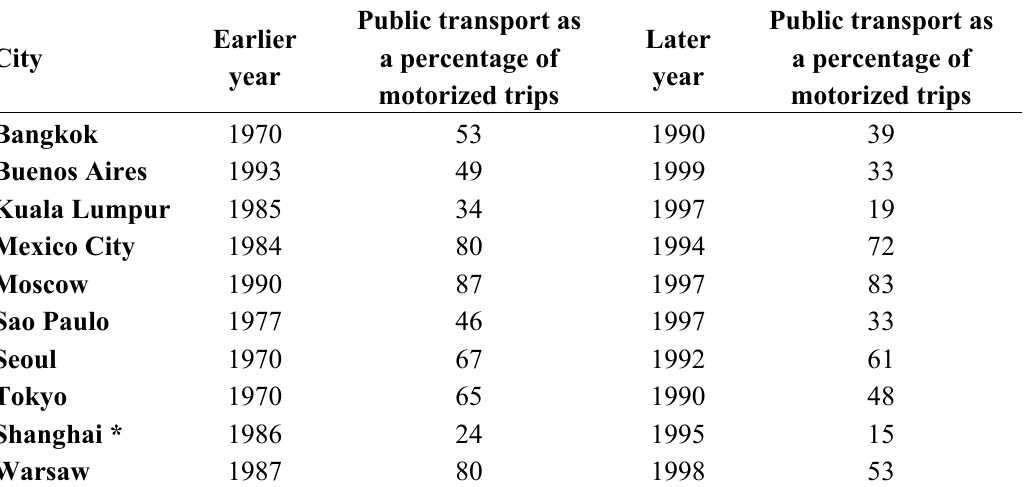
Table 2. Trends in mode share of public transport in selected